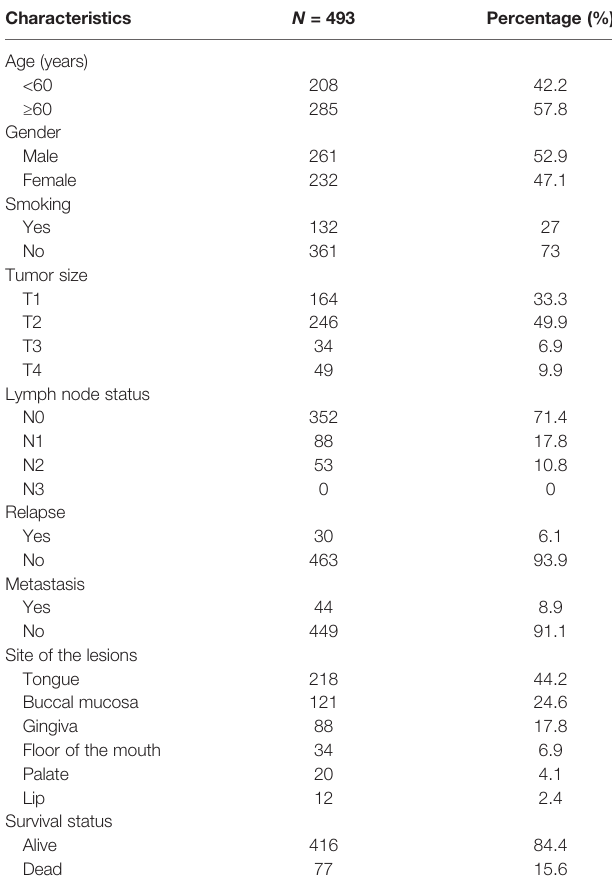
TABLE 1 | Clinico-pathological characteristics of patients with